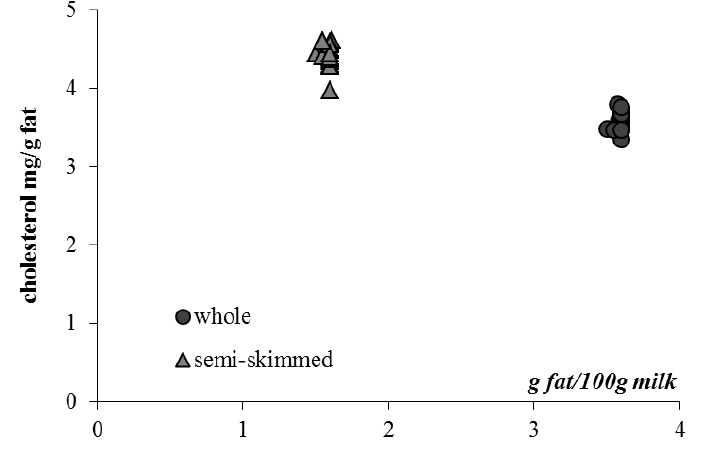
Figure 2. Cholesterol content (mg/g fat) vs . fat content (g/100 g) in whole and semi-skimmed commercial milk